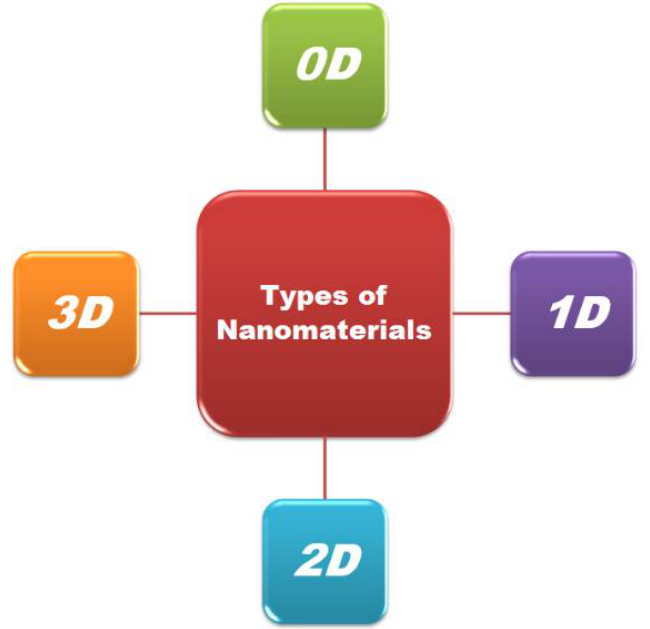
Figure 1. Classification of nanomaterials.